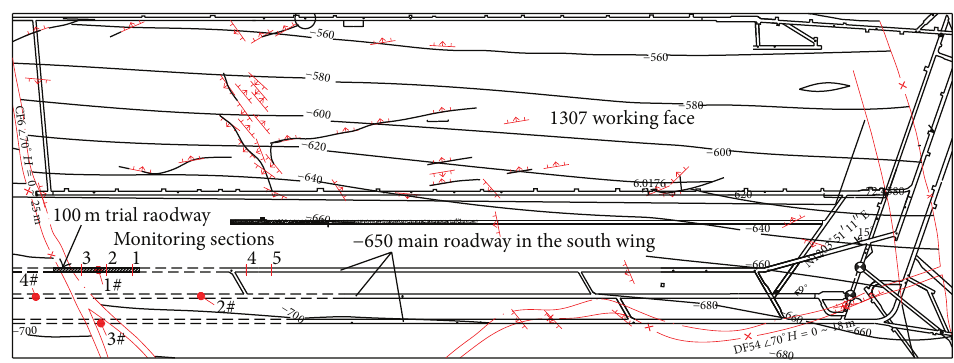
Figure 5: The locations of boreholes 1# ∼